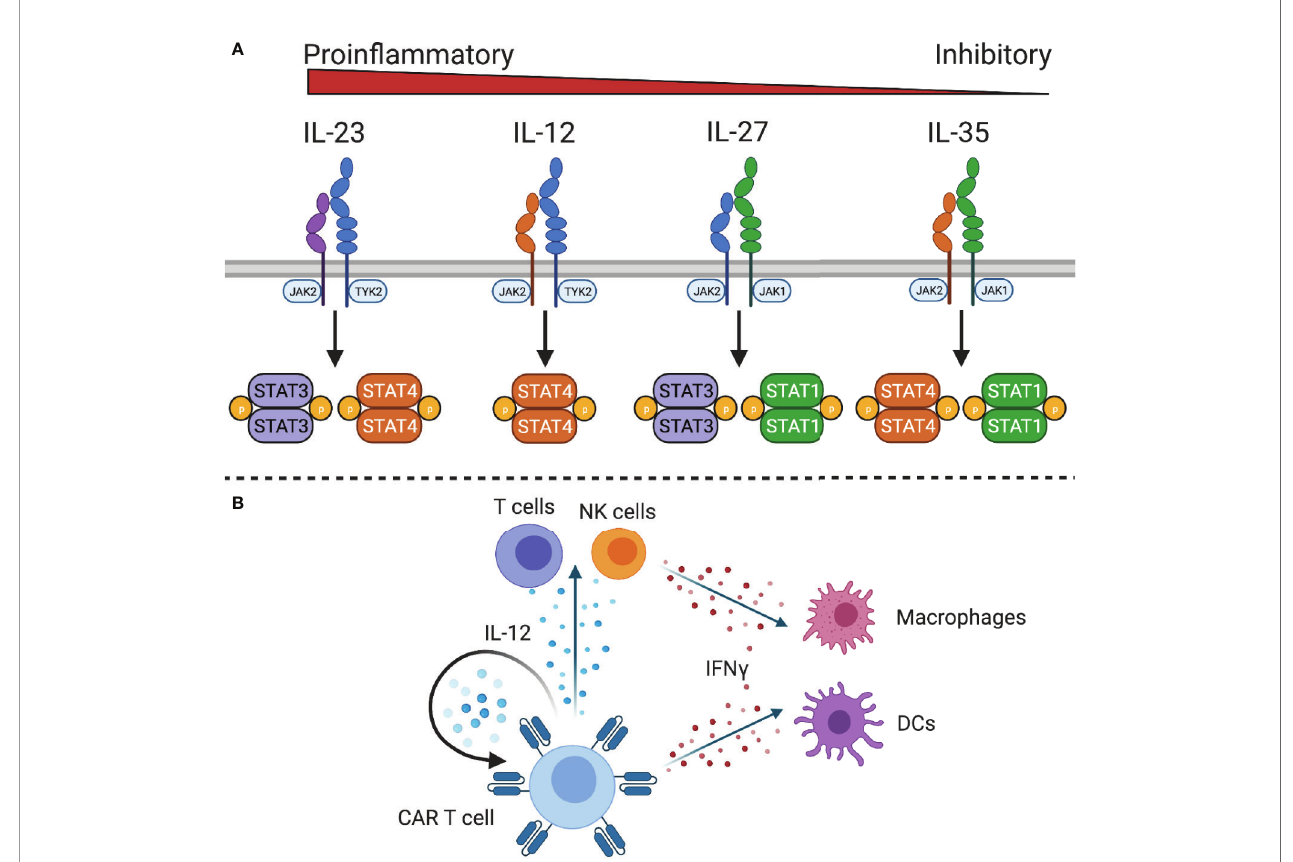
FIGURE 4 | IL-12 family cytokine signaling. (A) The IL-12 family cytokine receptors signal through different STAT family members to exert proin fl ammatory or inhibitory functions. (B) IL-12 expressing CAR T cells can stimulate IL-12 responsive CAR T cells and endogenous T and NK cells. Downstream mediators of IL-12, such as IFN g , can act on macrophages and dendritic cells to stimulate innate and adaptive